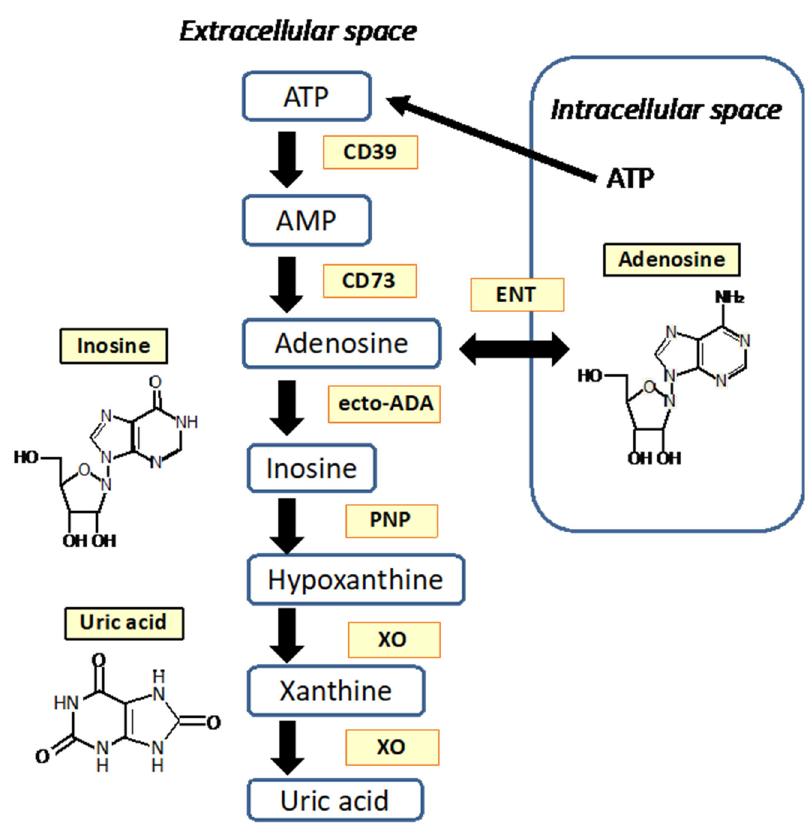
Figure 1. Extracellular adenosine production and metabolism. ATP: adenosine triphosphate; AMP: adenosine monophosphate; CD39: triphosphate diphophahydrolase-1; CD73: ecto-5 ′ nucleotidase; ecto-ADA: adenosine ecto-deaminase; ENT: equilibrative nucleotide transporter; PNP: purine nu- cleoside phosphorylase; XO: xanthine oxidase [19,20].